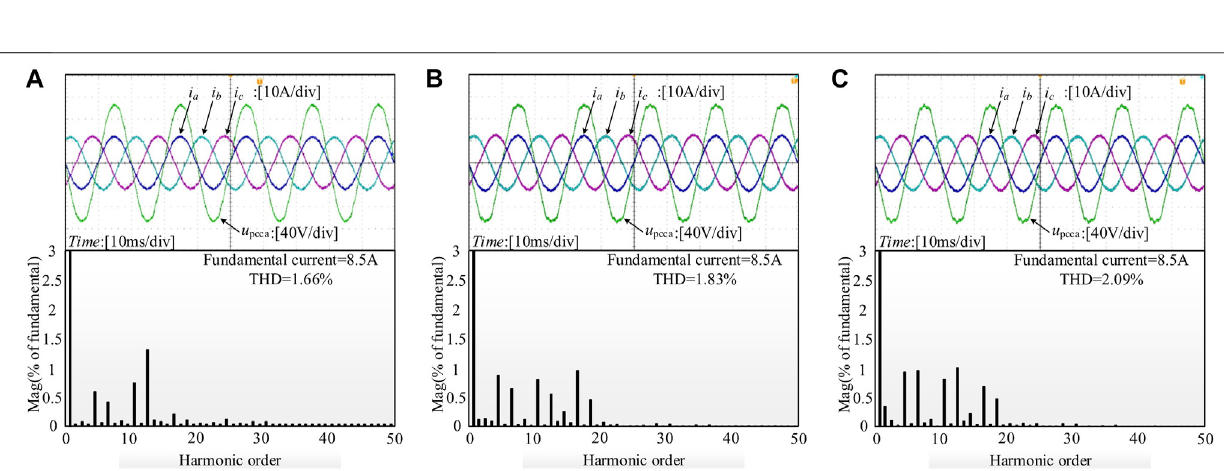
Frontiers in Energy Research |